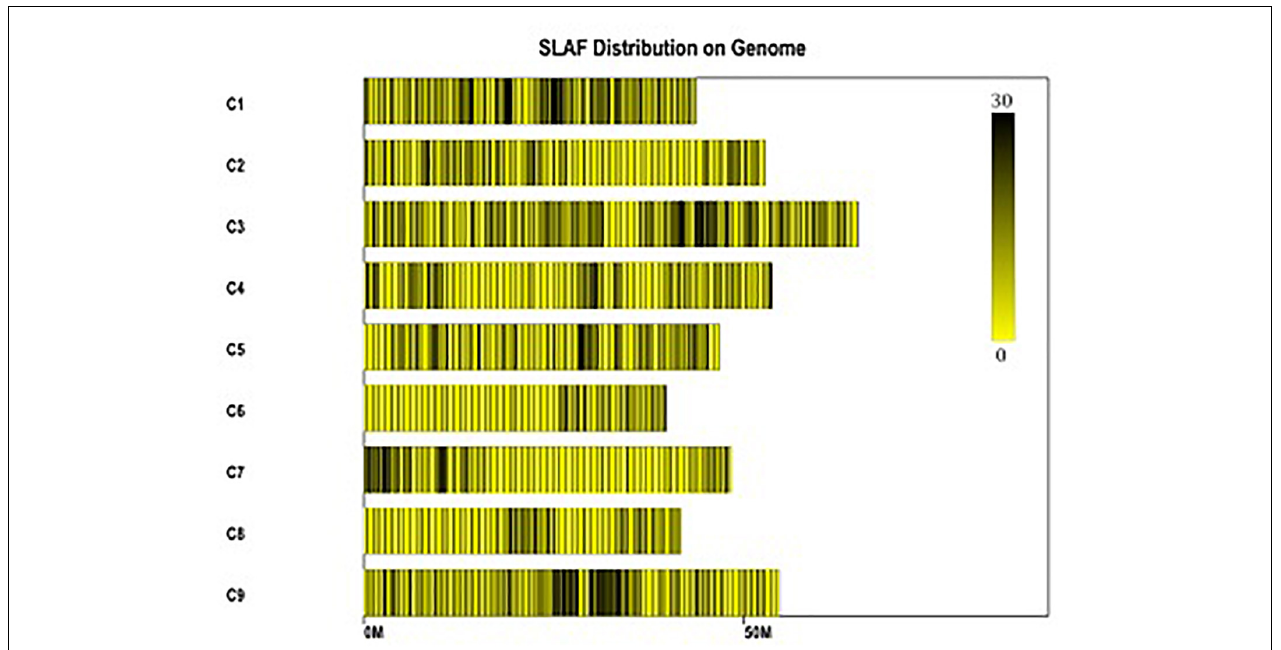
FIGURE 3 | Distribution of polymorphic SLAFs on the reference genome TO1000. The x -axis and the y -axis represent chromosome length and code, respectively. Each yellow bar stands for a chromosome, and deeper color from yellow to black means more SLAFs on the corresponding location.